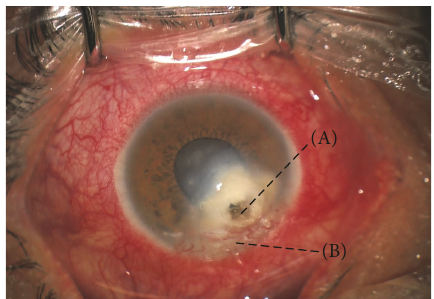
Figure 1: Clinical appearance of the patient before surgery. Please note a corneal perforation surrounded by a dense infiltrate (A) associated with inferior neovascularization